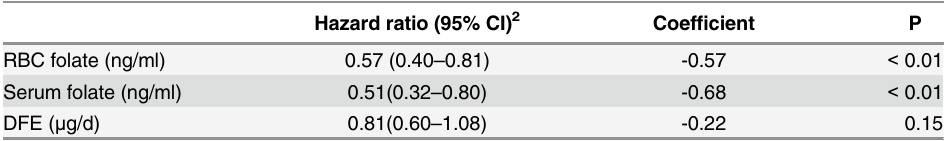
Table 3. Hazard ratios of overall cancer incidence and 95% confidence intervals (95% CI) by continu- ous levels of red blood cell (RBC) folate, serum folate, and dietary folate equivalents (DFE) 1 ,